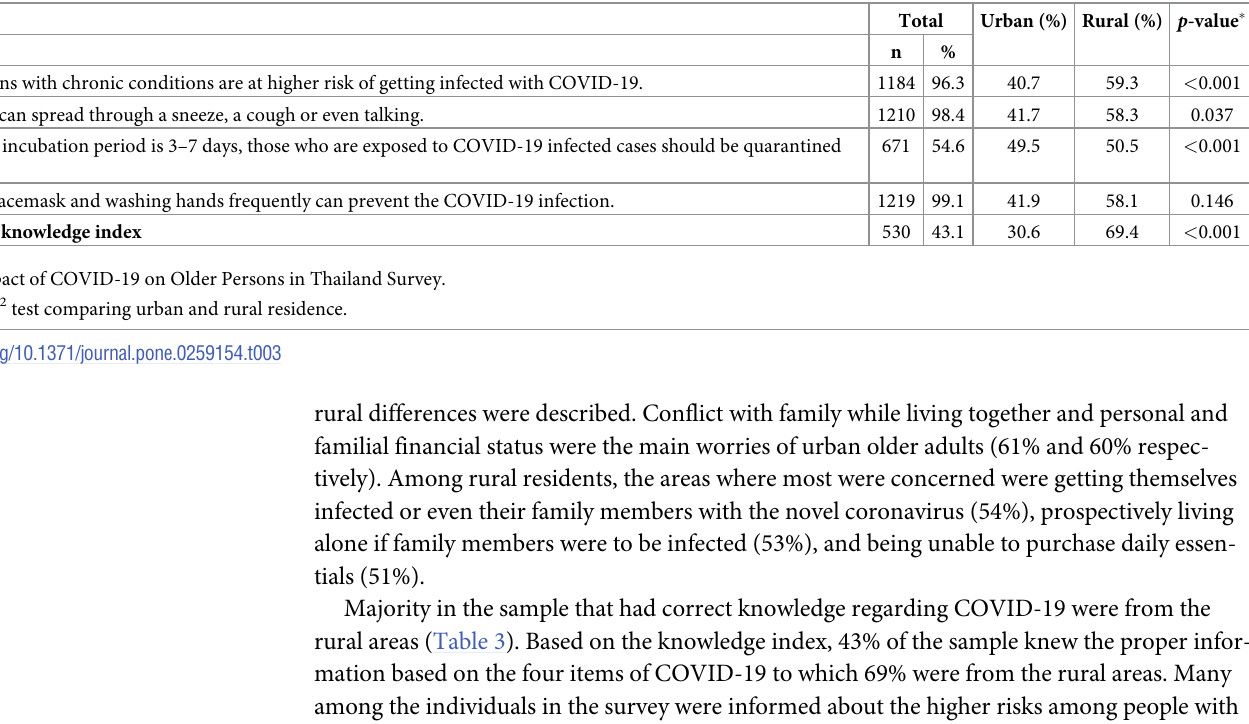
Table 3. Correct knowledge about COVID-19 by residential area.